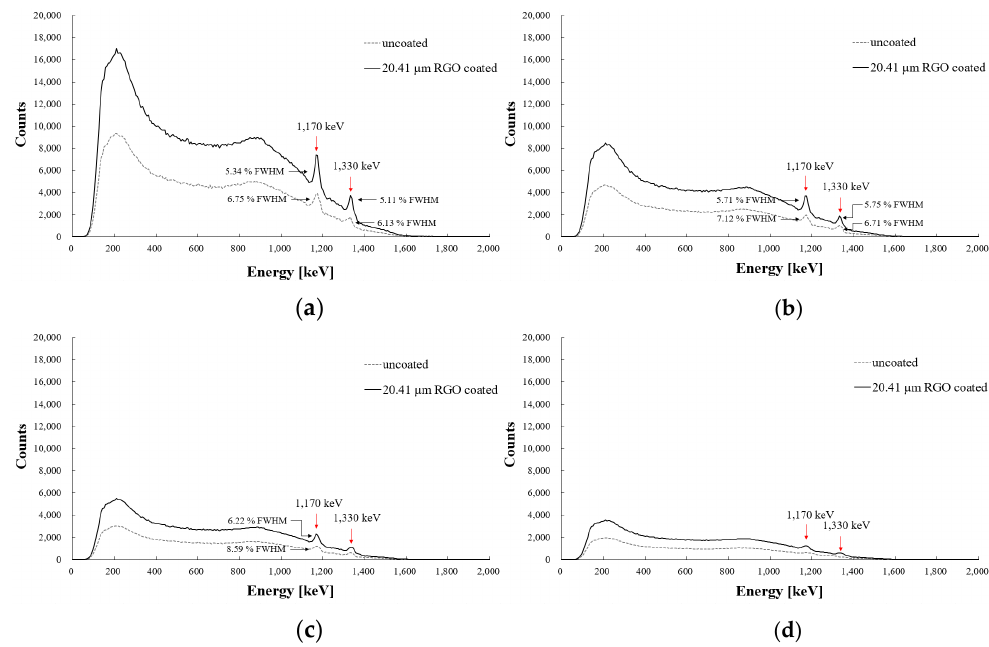
Figure 8. Energy spectra of the 60 Co radioisotope according to the lengths of a POF in the FORS. ( a ) 1 m, ( b ) 2 m, ( c ) 2.5 m, and ( d ) 3 m.